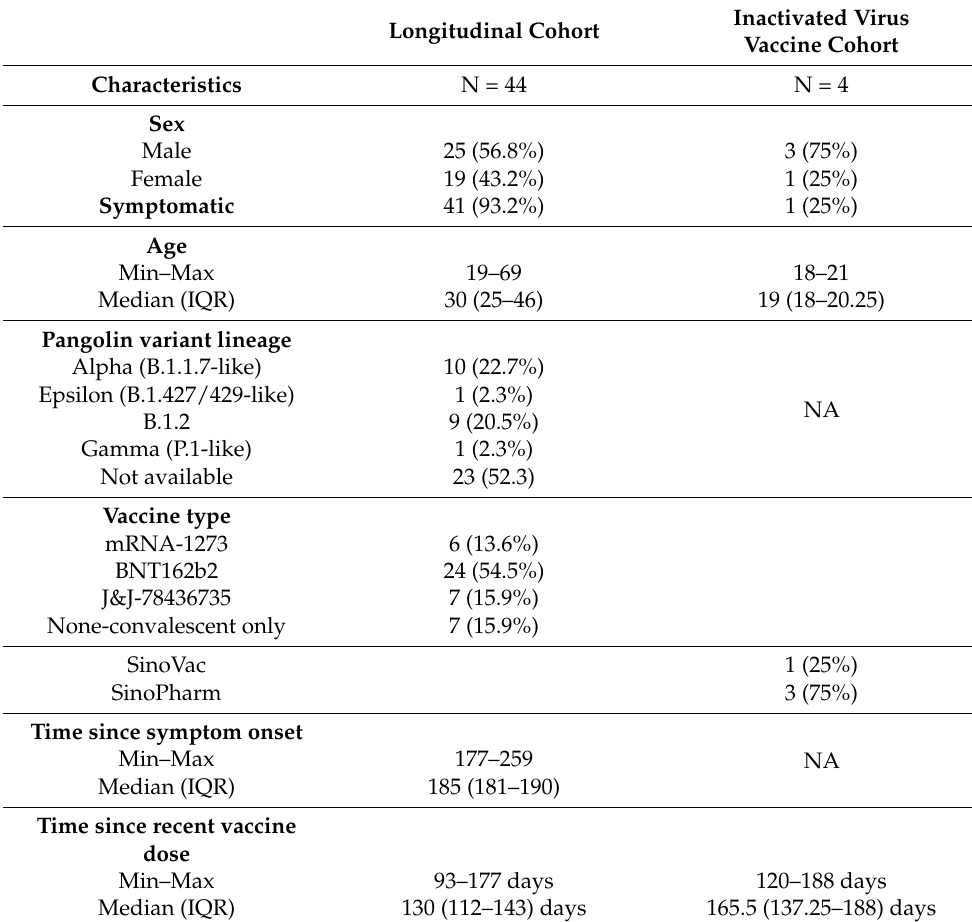
Table 2. Characteristics of convalescent-vaccination serum.